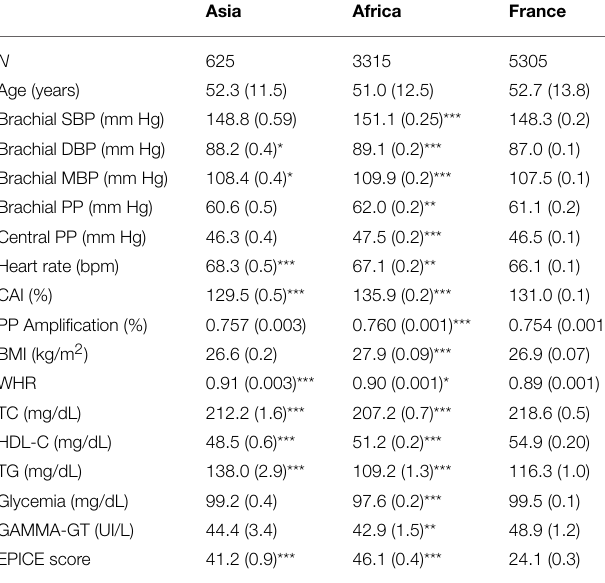
TABLE 2 | Main characteristics (with standard deviation) of the entire population ( N = 56 ,242 men and women) according to country of birth. Asia